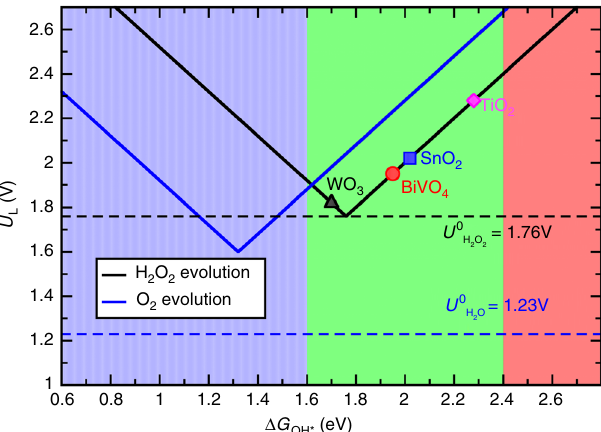
Fig. 1 Activity volcano plots. It is based on calculated limiting potentials as a function of calculated adsorption energies of OH* ( Δ G OH (cid:5) ) for the two-electron oxidation of water to hydrogen peroxide evolution ( black ) and the four-electron oxidation to oxygen evolution ( blue ). The corresponding equilibrium potentials for each reaction have been shown in dashed